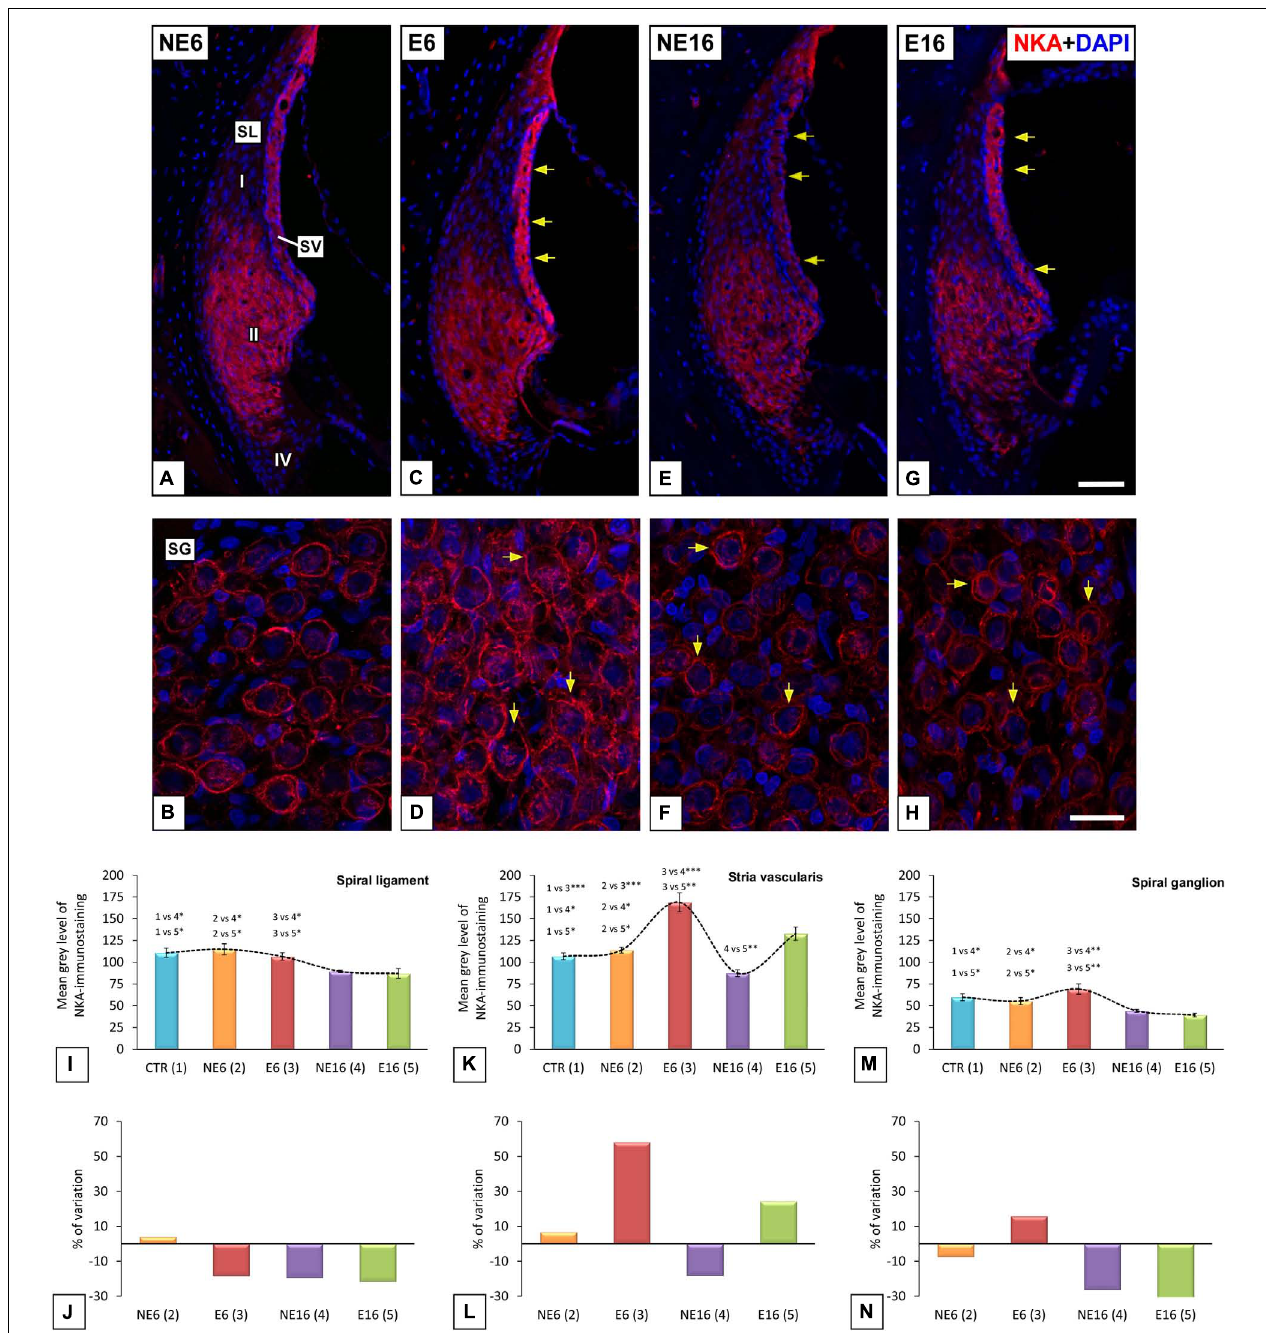
FIGURE 4 | Digital images illustrating NKA-immunostaining in NE6, E6, NE16, and E16 rats. Noise exposure in adult (E6) rats leads to increased staining levels in SV (arrows in C ), and SG (arrows in D ) compared to NE6 (A,B) , NE16 (arrows in E,F ) and E16 (arrows in G,H ) rats. Note, however, that staining levels in the SL and SG of aged cochleae (arrows in E–H ) were decreased relative to young (A–D) rats. The quantification of the mean gray levels of NKA-staining (I–M) and the percentage of variation (J–N) for each cochlear structure and animal group confirmed the histological data. Cell nuclei (blue) were counterstained with DAPI.SL, spiral ligament; SV, stria vascularis. ∗ p < 0.05; ∗∗ p < 0.01; ∗∗∗ p < 0.001. Scales bars: 50 µ m in (G) ; 20 µ m in (H) . n = 4 for each animal group.